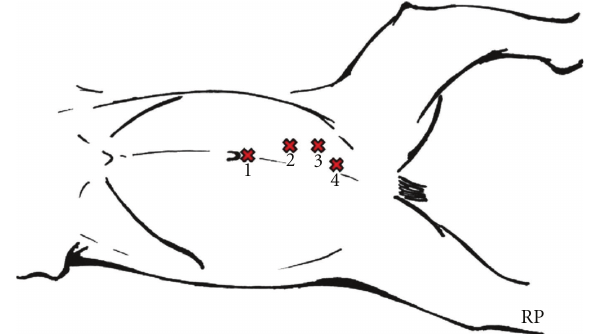
Figure 1: Insertion sites for the open approach midline subum- bilical placement of the primary 10mm optical port (1), 5mm retractor port, (2) and the two 5mm instrument ports (3, 4).